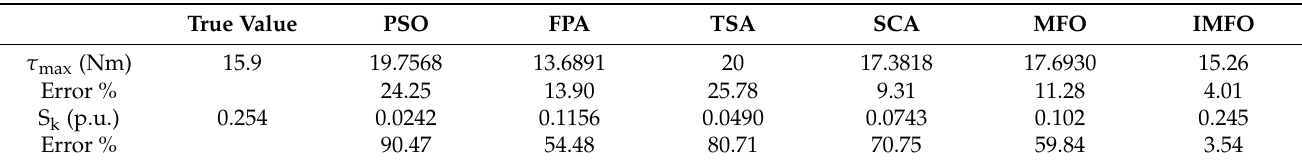
Table 4. Error of all compared algorithms.